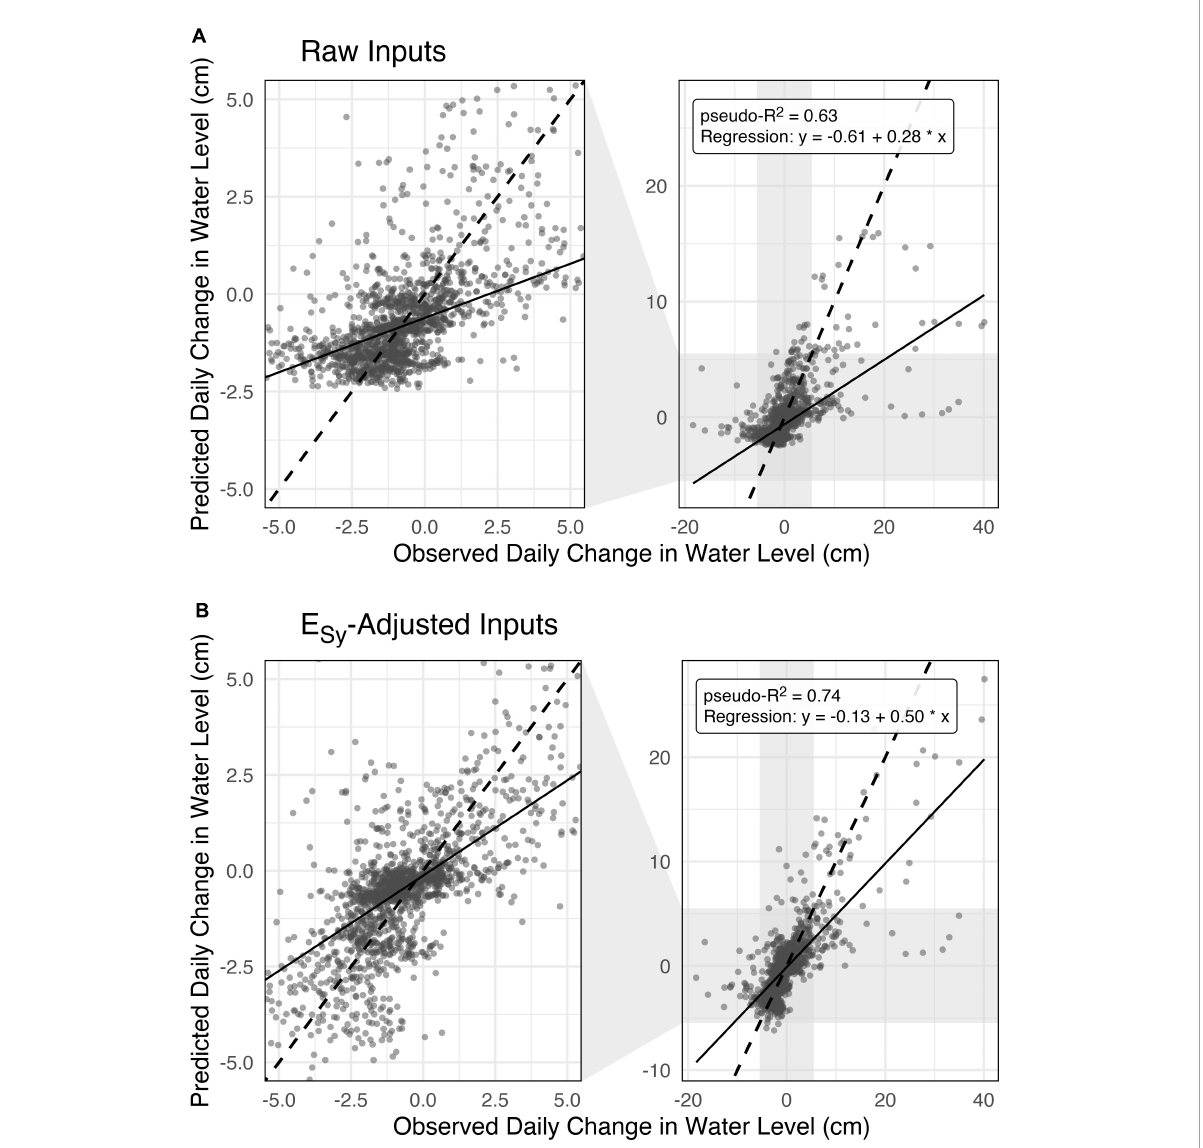
FIGURE2 Predictions of daily change in water level using a quantile regression with observed daily water level as the dependent variable and potential evapotranspiration (PET), rainfall, and snowmelt as the independent variables. The model was fit two times, once with raw hydrologic inputs (A) and once with inputs adjusted by ecosystem specific yield (B) . The right panels show the full dataset while the left panels zoom in on an interval [-5, 5] for both the observed and predicted water levels. The dashed line shows a 1:1 line and the solid line shows a quantile regression ( τ = 0.5) between predicted and observed water